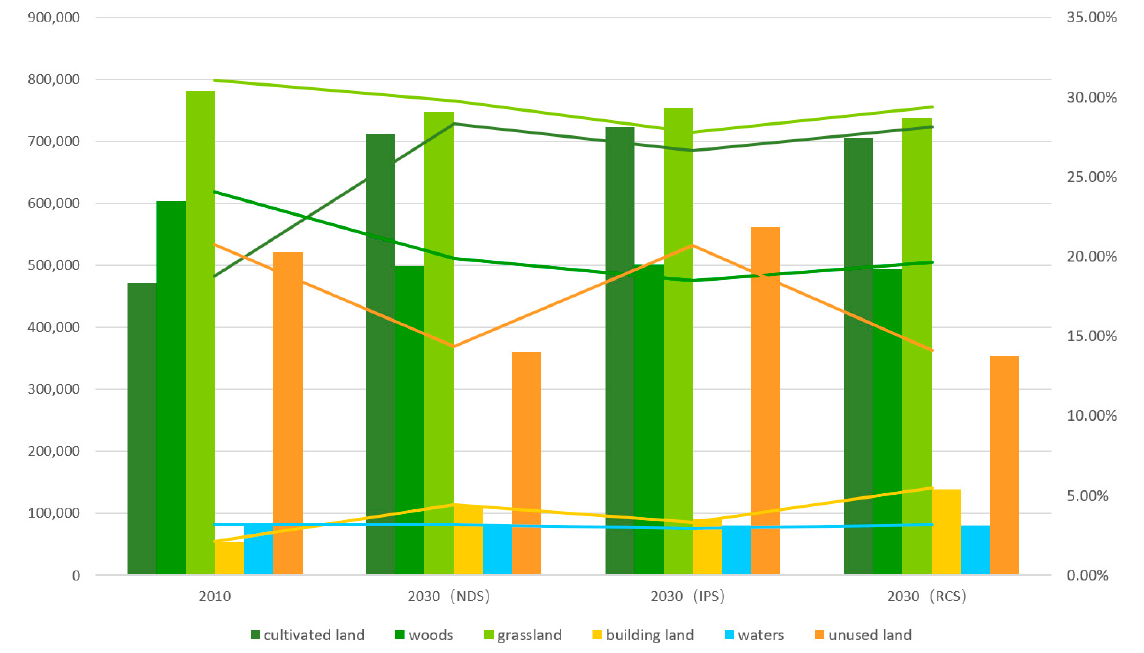
Figure 3. Land use changes under three scenarios. (Unit: hm 2 ).